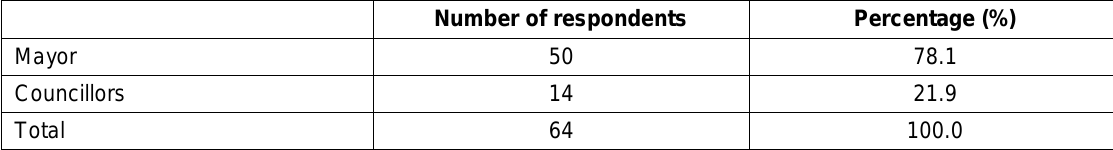
Table 10: Views on who is the vital role player in decision-making (general